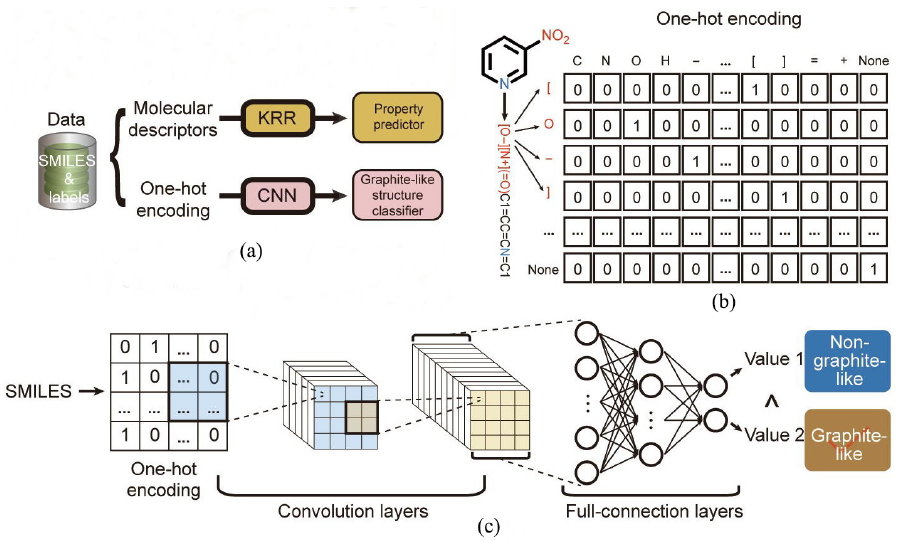
Figure 5. Framework and components of the system. ( a ) Schematic of the training of property models (kernel ridge regression-KRR) and the graphite-like structure classification model. ( b ) One-hot encoding for the input of the CNN. ( c ) Architecture of the CNN [1]. Copyright 2022 Elsevier LTD.